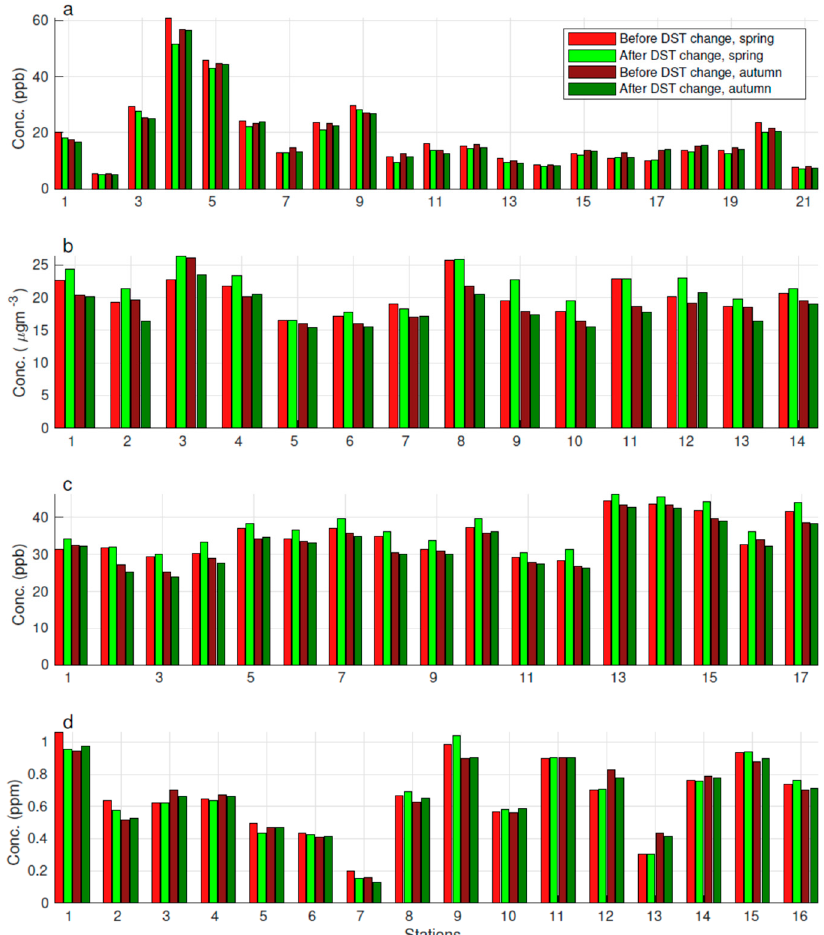
Figure 6. Mean concentrations during five working days before and after the DST changes. ( a ) NOx, ( b ) PM 2.5 , ( c ) O 3 and ( d ) CO. For visual purposes, the x -axes labels of the NOx and O 3 plots contain only odd numbers.